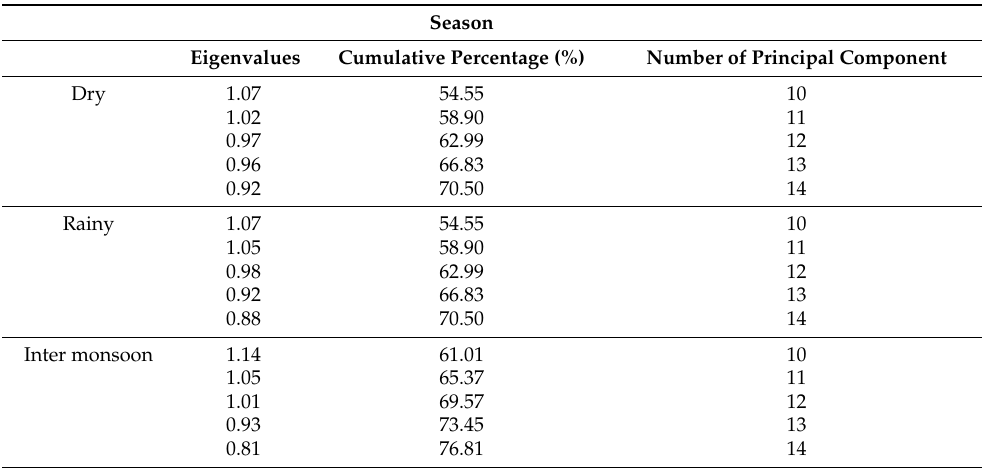
Table 4. Summary of the PCA results for eigenvalues, percentage of variation and number of components obtained for each season in Yogyakarta,